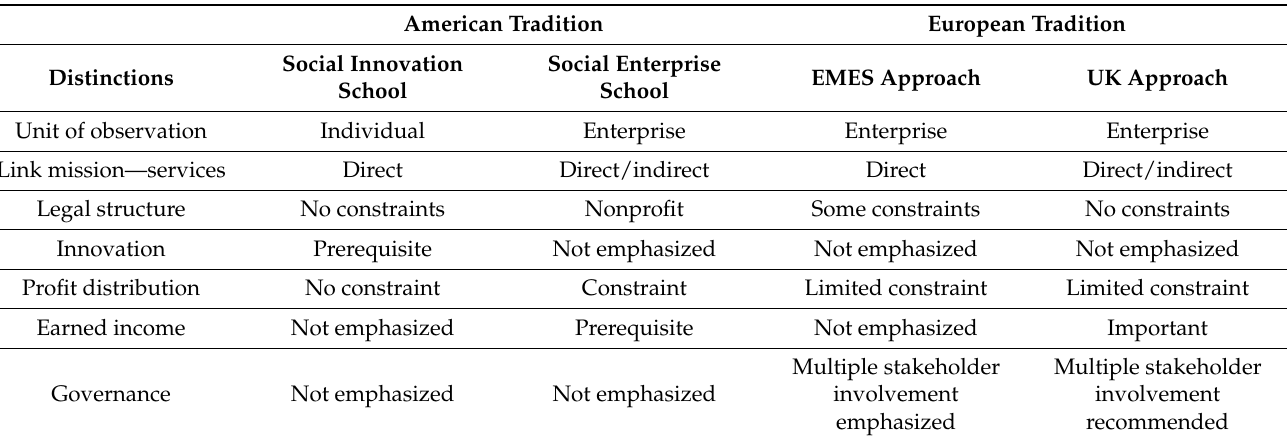
Table 1. SE schools of